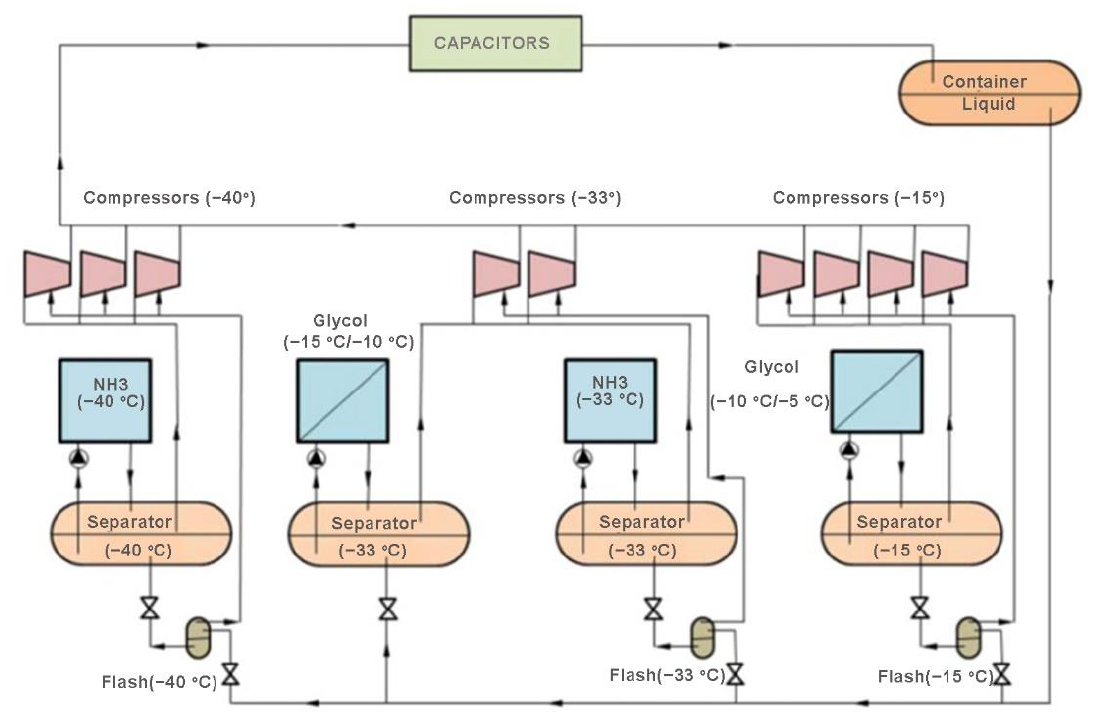
Figure 4. Refrigeration system main diagram.